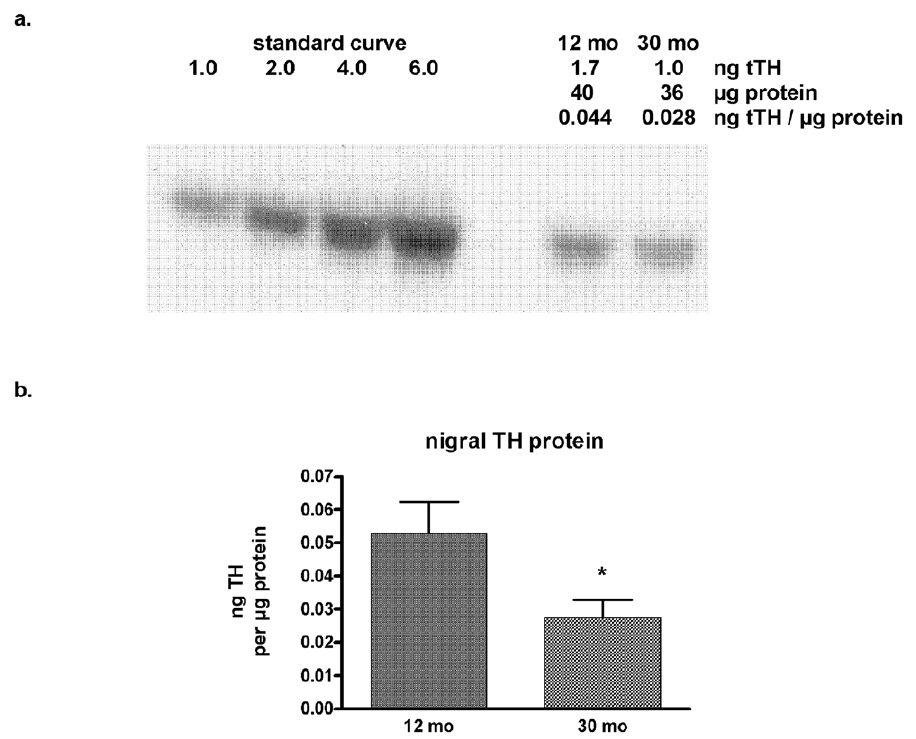
Figure 7. Nigral TH protein loss in aging. a. Representative blot showing the , 40% decrease in total TH (tTH) protein in the SN in a 30-month old BNF rat compared to the tTH content in the 12-month old. All TH protein assays are conducted against a standard curve with quantified TH protein. A specific quantity of total protein is loaded from the sample to determine the ng tTH per m g protein and the quantity from the sample is interpolated from the standard curve. b. nigral total TH protein content between the 12- and 30-mo old subjects, 0.053 6 0.010 and 0.028 6 0.005 ng per m g protein, respectively. p , 0.05 (Student’s t-test, unpaired).